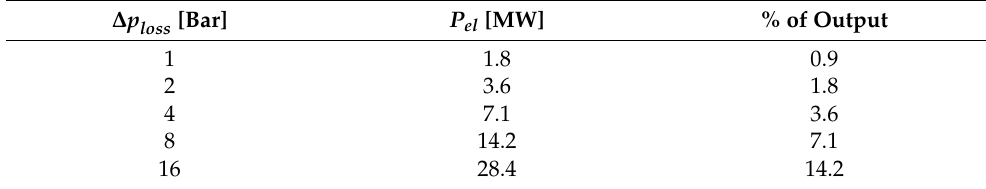
Table 4. Estimated electrical power consumption for pumping FLiBe with increasing PEXS pressure